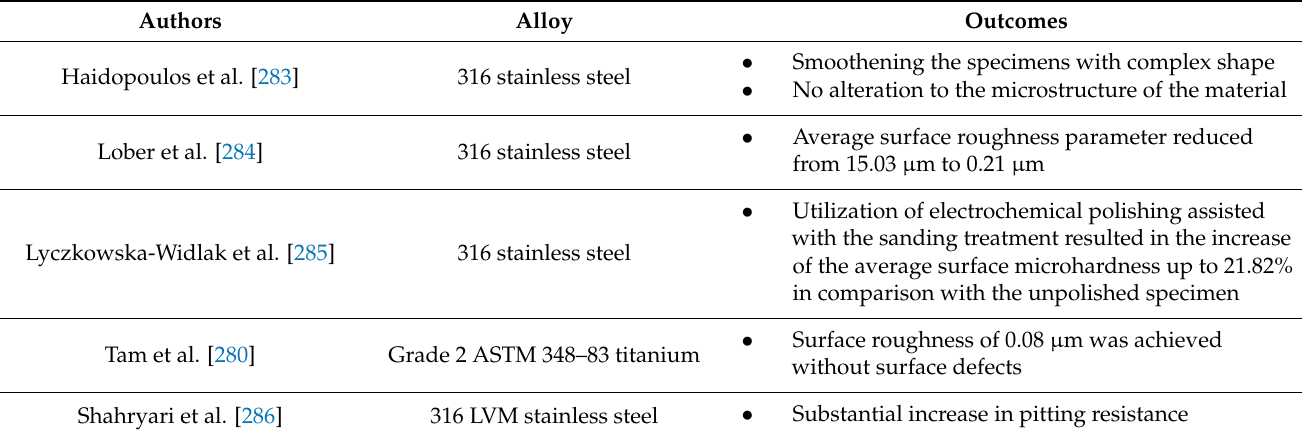
Table 22. Electropolishing method on several biomedical